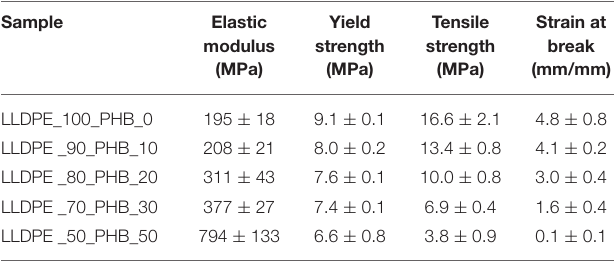
TABLE 2 | Results of quasi-static tensile tests on neat LLDPE and relative LLDPE/P(3HB) blends.